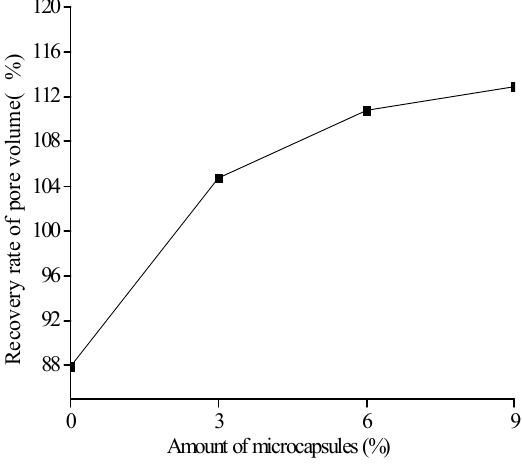
Figure 21. Recovery rate (Equation (7): η RP ) of porosity with amount of microcapsules.